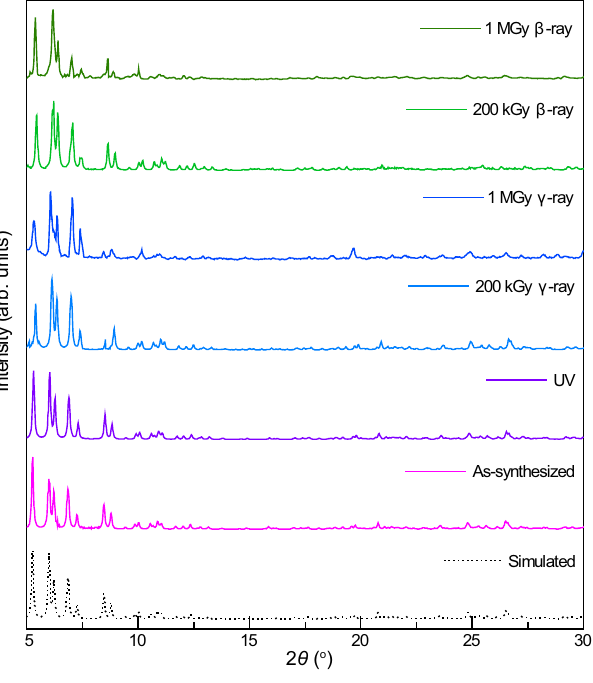
Fig. 4 Radiolytic stability of Th-SINAP-100. PXRD patterns of Th-SINAP- 100 before and after irradiation with UV, β -ray, or γ